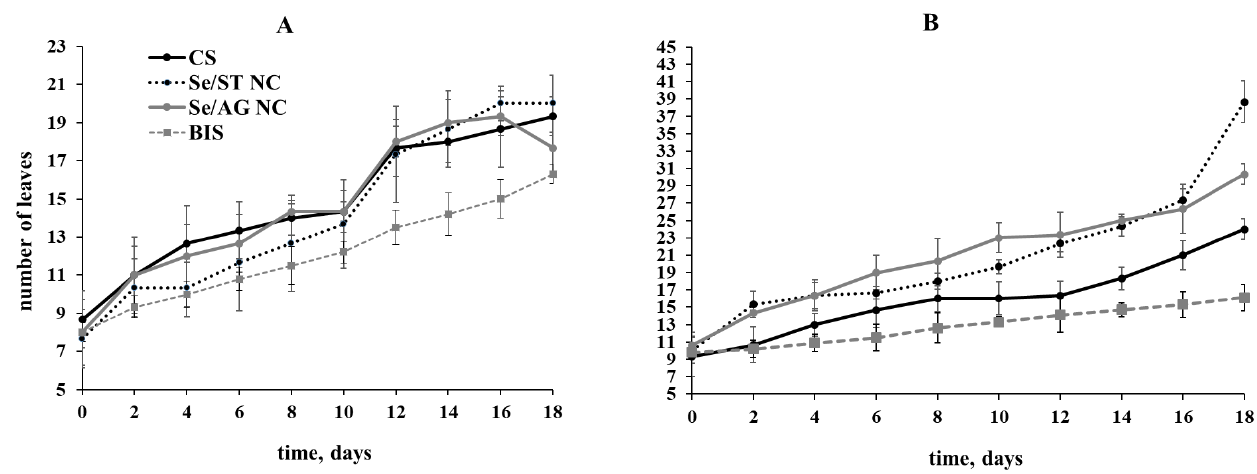
Figure 5. Effect of treatments by Se/AG and Se/ST NCs on the number of leaves in Lukyanovsky ( A ) and Lugovskoy ( B ) potato varieties in vitro; CS—control samples. Table 1. Effect of Se/AG and Se/ST NC treatments on the morphometric traits and peroxidase activity in infected potato plants in vitro .